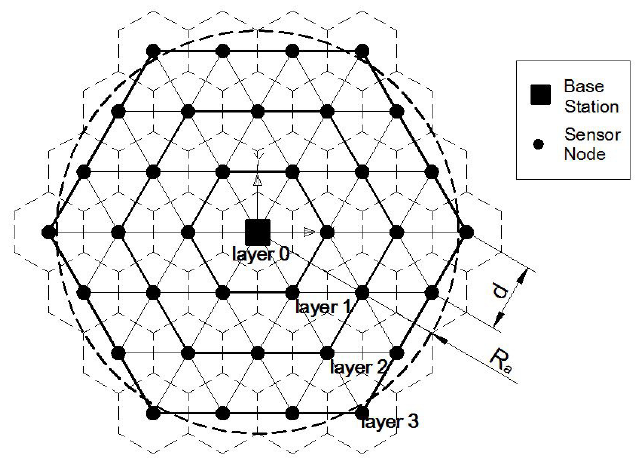
Figure 1. The topology of homogeneous